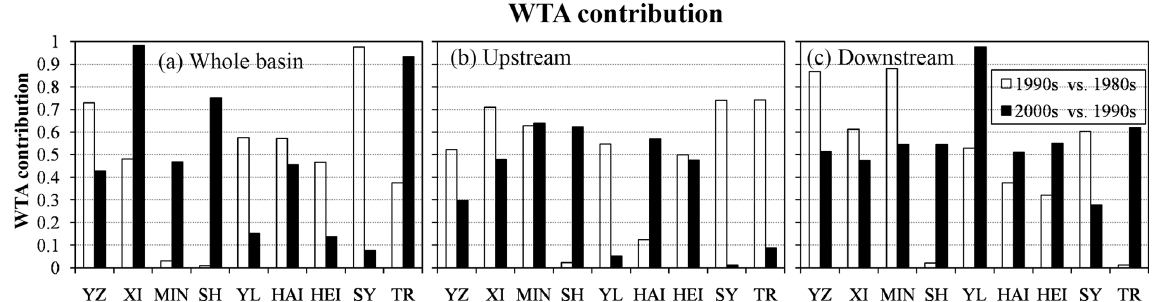
Figure 8. The WTA contribution in water scarcity trajectories for whole basin, upstream regions, and downstream regions between different